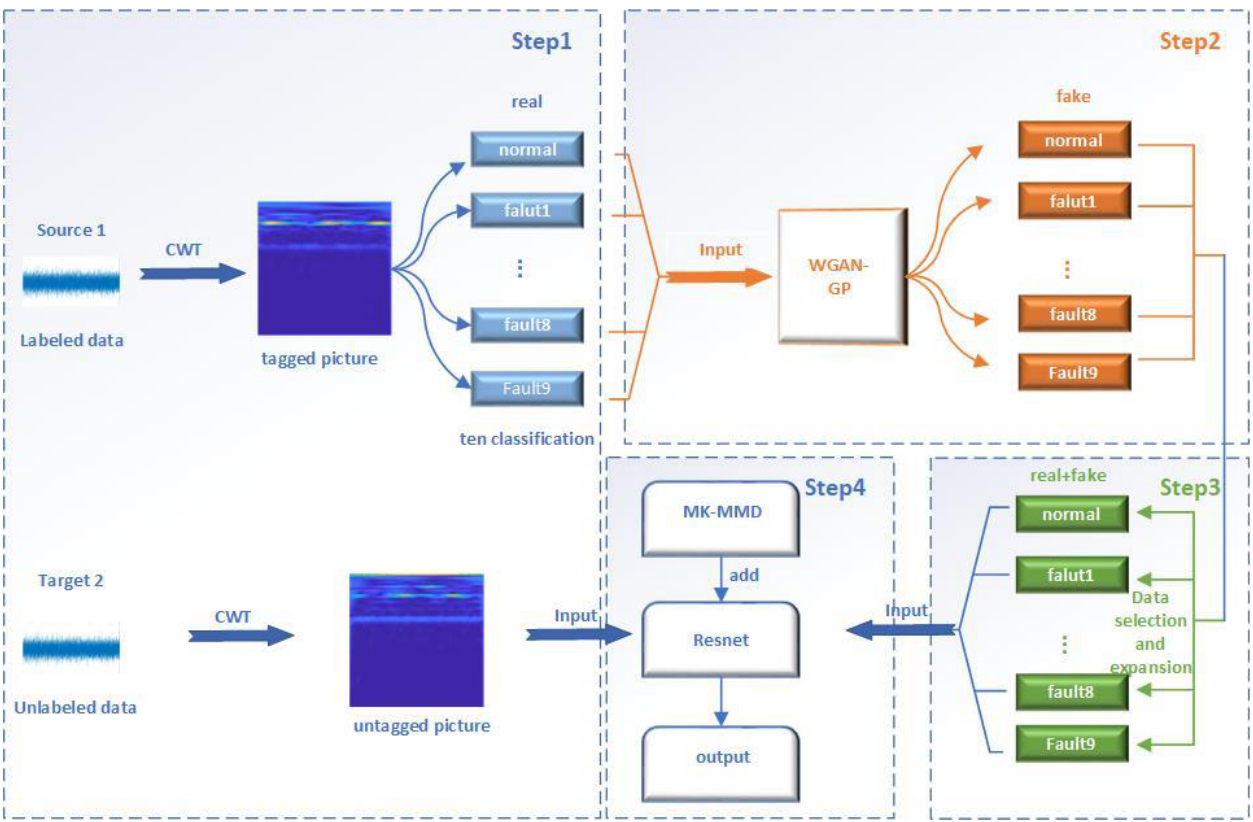
Figure 1. Fault diagnosis process